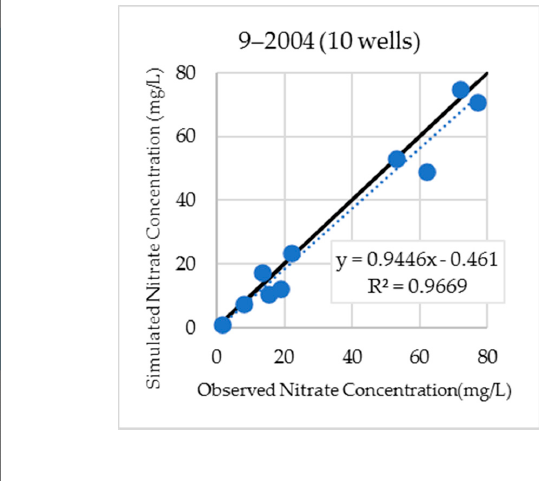
( b ) Figure 19. ( a ) Isonitrates contours for March 2013 and ( b ) scatterplot of simulated against observed nitrates concentration values.